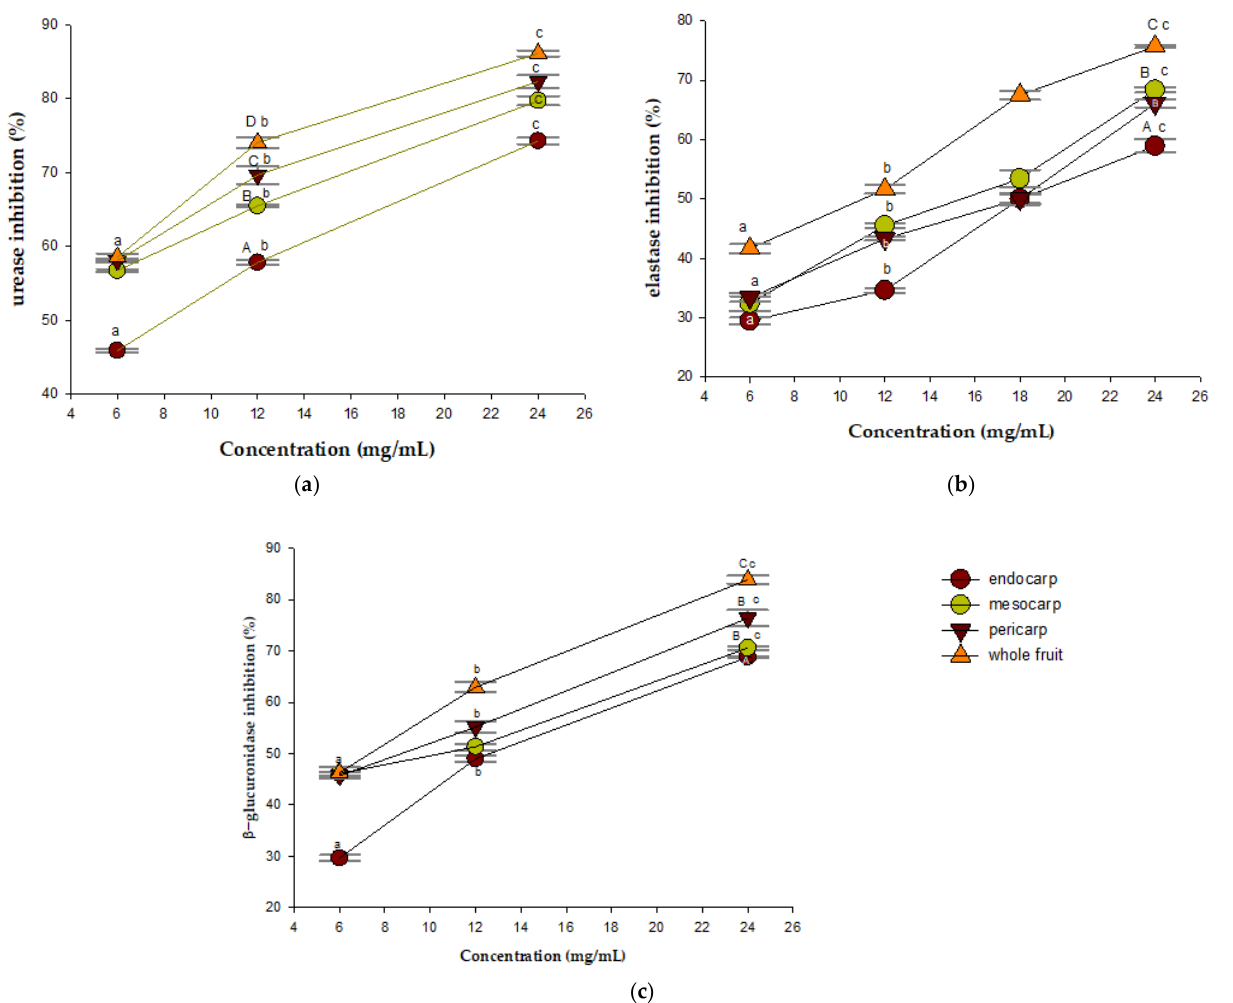
Figure 2. Urease (%) ( a ), elastase (%) ( b ) and β -Glucuronidase (%) ( c ) inhibition. The lowercase letters a, b, c represent the significant differences ( p < 0.05) between the concentrations and the uppercase letters A, B, C mean the significant differences ( p < 0.05) between the extracts; the data were analyzed with a Tukey